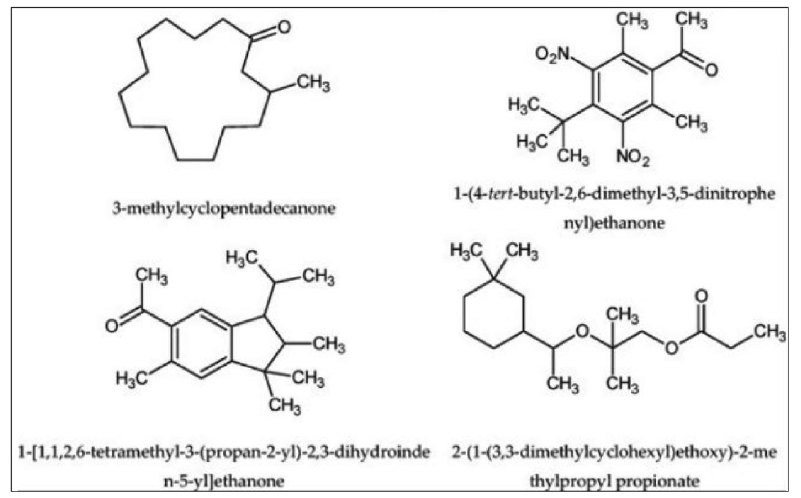
Figure 2. Examples of odorants with different structures but similar odor (musk).